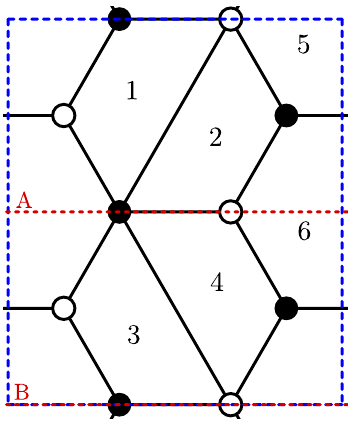
Figure 6. Dimer diagram for PdP 3 b with two horizontal fixed lines (dotted